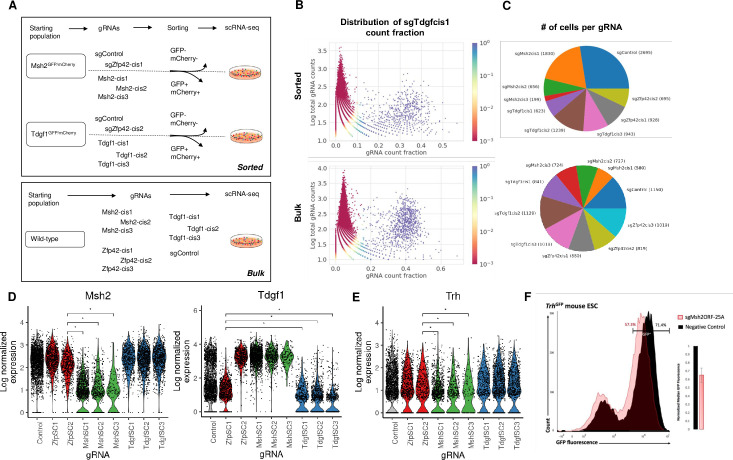
pAC-Seq faithfully recovers gRNA identity and transcriptomic differences in pooled single cell RNA-seq of pre-sorted populations.(A). Schematic of two pAC-Seq experimental schemes. In the top experiment, Msh2GFP/mCherry and Tdgf1GFP/mCherry mESCs were each targeted with three cis-gRNAs, and GFP-mCherry- cells were flow cytometrically purified. These same cell lines were each also targeted with two control gRNAs which do not cause loss of target gene expression such that gRNA identity should be highly correlated with target gene expression. The ten populations were pooled for single cell RNA-sequencing (scRNA-seq) on ~10,000 cells. In the bottom experiment, wildtype mESCs were separately targeted with ten gRNAs, one control and three cis-gRNAs each targeting Msh2, Tdgf1, and Zfp42 regulatory regions. The ten populations were pooled for scRNA-seq on ~10,000 cells. (B). Plot showing sgTdgfcis1 gRNA counts as a fraction of all gRNA counts (X-axis) in each cell, plotted against the total gRNA counts in that cell (Y-axis) for the sorted experiment (top) and unsorted experiment (bottom). The coloring represents the probability in the binomial mixture model that sgTdgfcis1 is observed through noise. A clear population can be distinguished in blue (p<0.05) in which the cell is called as containing sgTdgfcis1. (C). Pie chart showing the number of cells assigned to each of the ten gRNAs in the sorted (top) and unsorted (bottom) experiments. (D) Violin plots showing log normalized expression of Msh2 (left) and Tdgf1 (right) with transcript-targeted sequencing in the sorted experiment. * denotes statistical significance at adjusted p-value < 0.05. (E) Box plots showing log normalized expression of Trh, which is downregulated in cells that received sgMsh2cis1-3. * denotes statistical significance at adjusted p-value < 0.05 (F) Flow cytometry histogram of Trh-GFP fluorescence in cells with Msh2-ORF targeted knockout (pink) or control gRNA (black), showing that Msh2 knockout subtly downregulates Trh expression. Inset plot shows normalized GFP fluorescence averages in three biological replicate experiments.